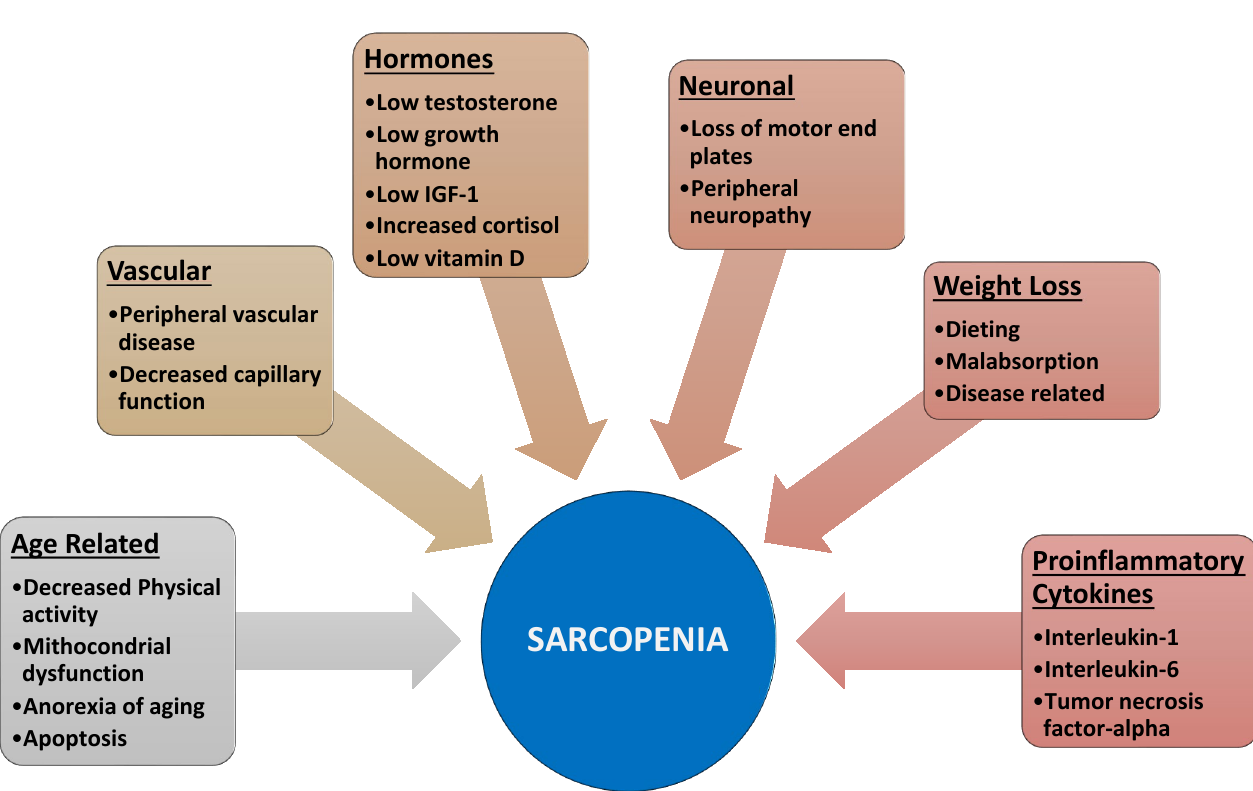
Figure 1. Physiopathological processes of sarcopenia (from Morley JE, et al. 2014, modified [15]). Overall, SP is closely related to the patient’s general condition and can affect both tumor progression and treatment tolerability